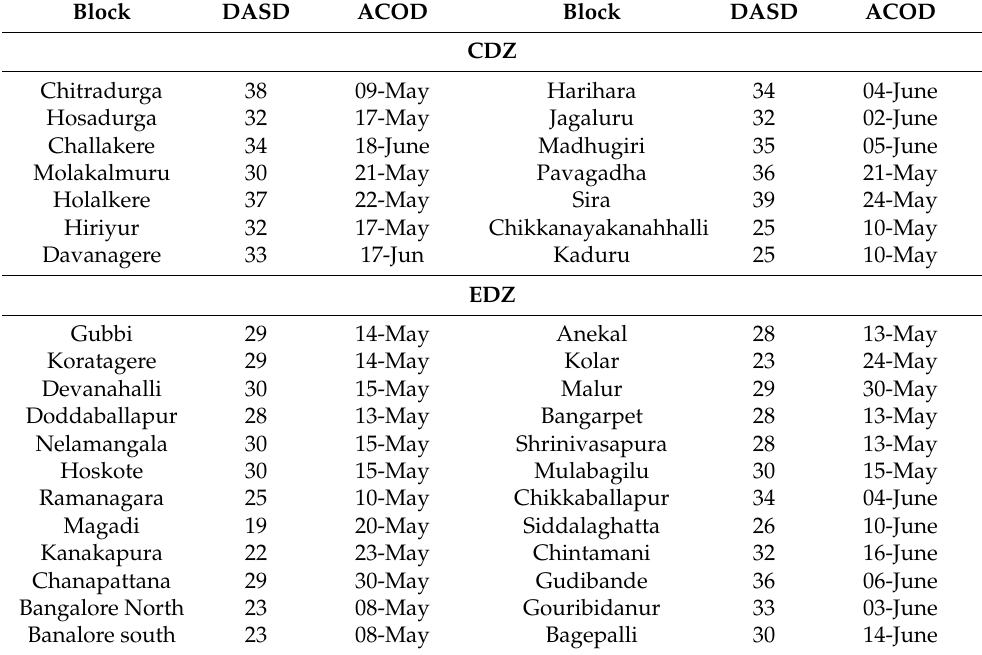
Table 8. The agro-climatic onset of monsoon over SIK (zones CDZ, EDZ and SDZ, subdivided into blocks) expressed in terms of days after the start date and actual